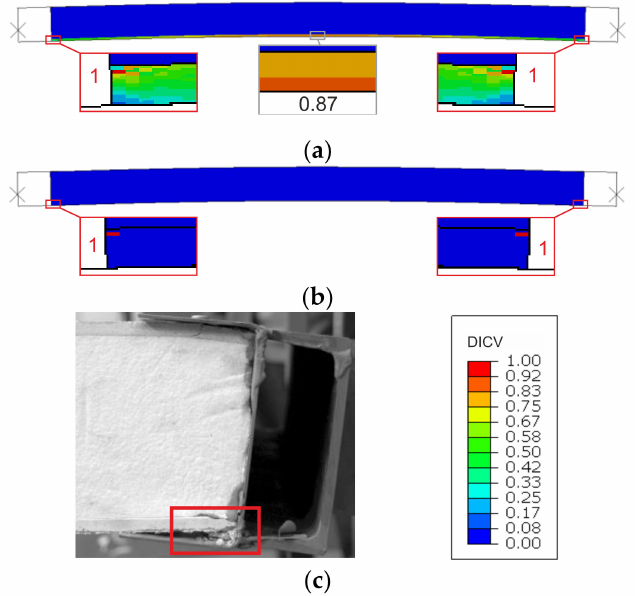
Figure 15. Comparison of failure modes in natural-scale e1 panel compression test; FEA